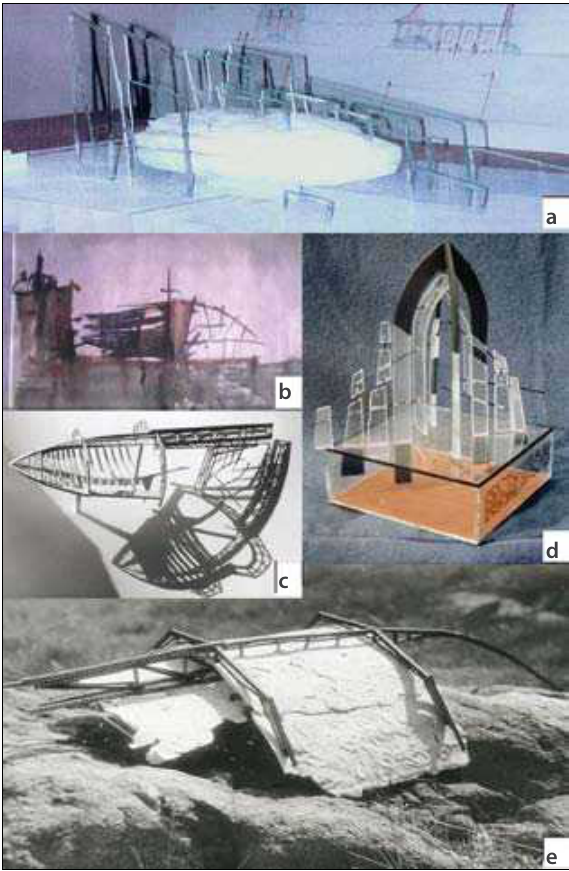
Fig. 7. Examples of students’ works. Third/fourth study years: a, d – study of structural analysis and compositional inter- pretation (VGTU); b, c, e – tectonic interpretation of urban pattern